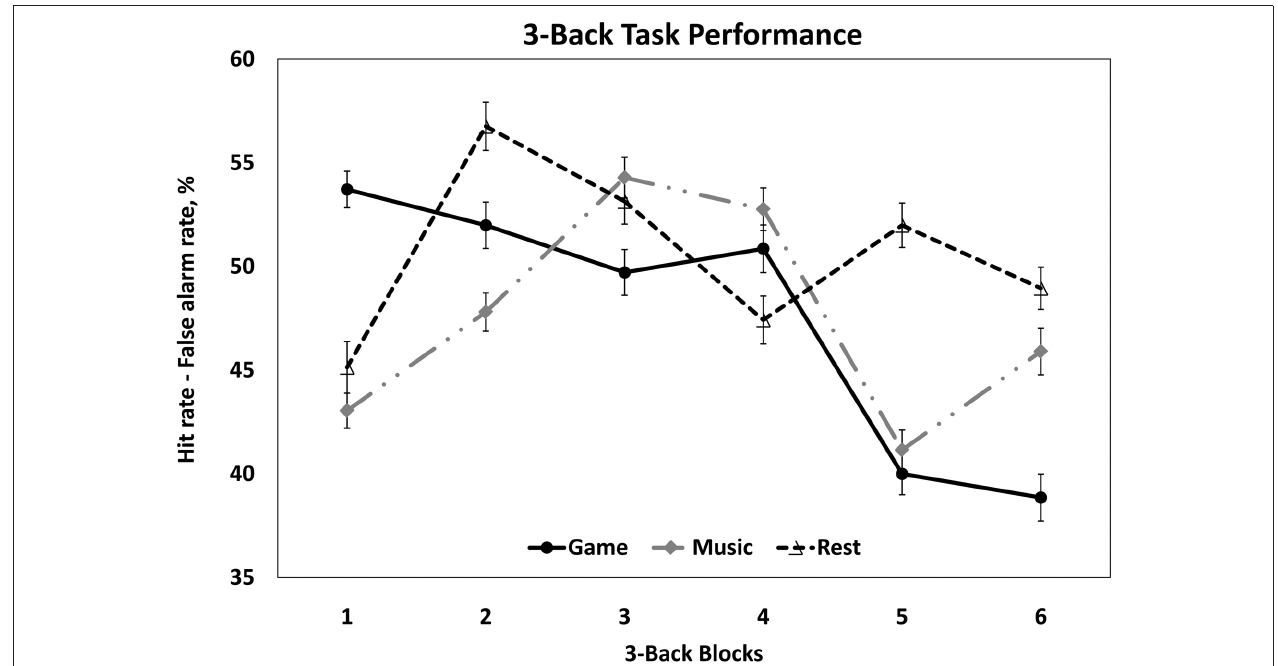
FIGURE 3 | Mean task performance in 3-back as a function of block ( n -back block 1 to 6) and break activity (game vs. music vs. rest). Error bars represent standard errors of the mean.